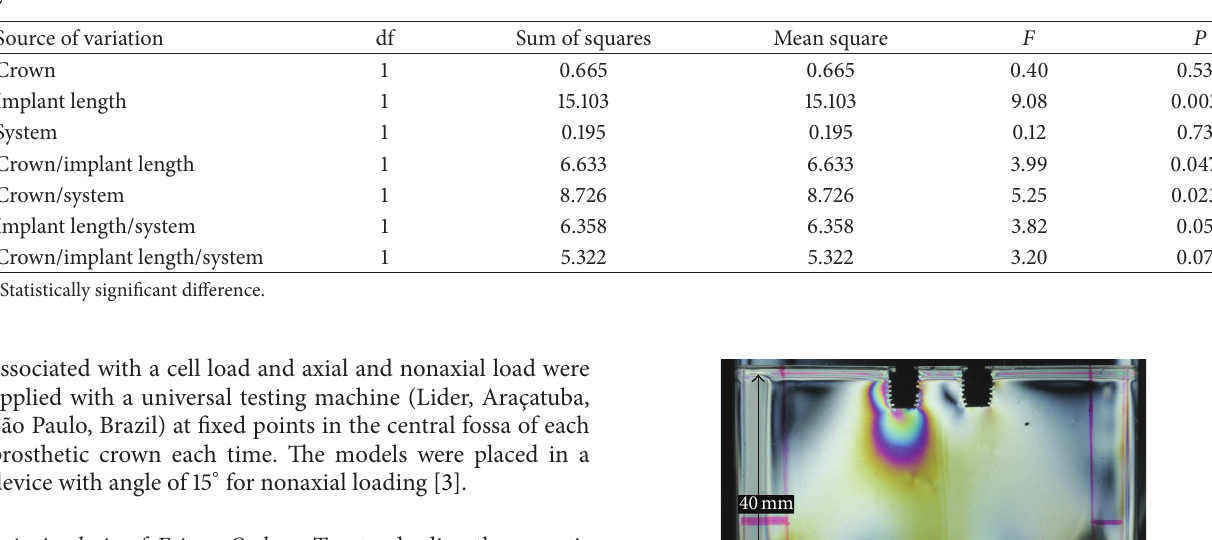
Table 2: Three-way ANOVA for stress distribution under axial loading, based on the factors crown height, implant length, and implant system.